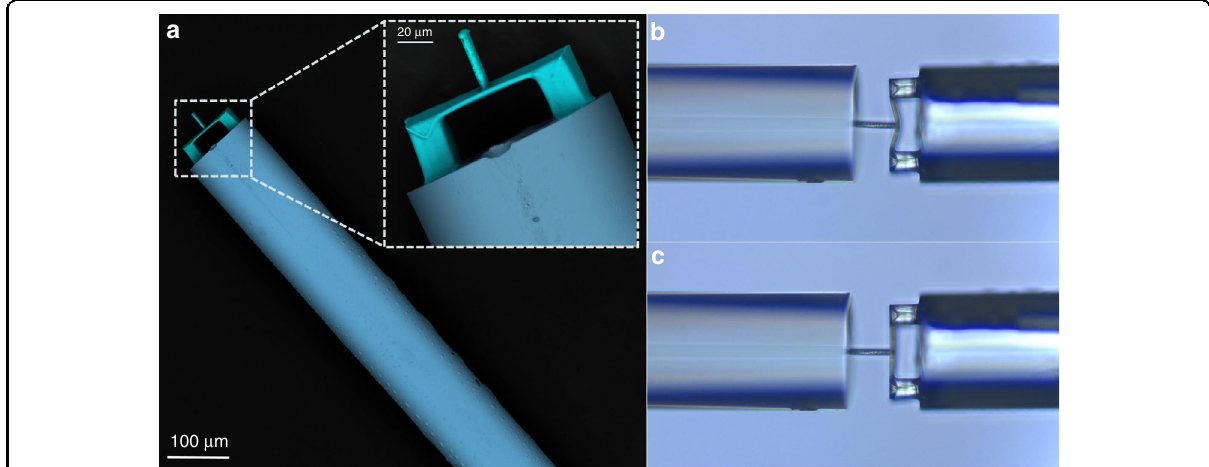
Fig. 3 SEM images and elastic properties. a SEM images of fabricated polymer clamped-beam probe on the fi ber tip. b , c are optical microscope images of the clamped-beam probe structure when pressed and released on the fi ber-end surface, respectively